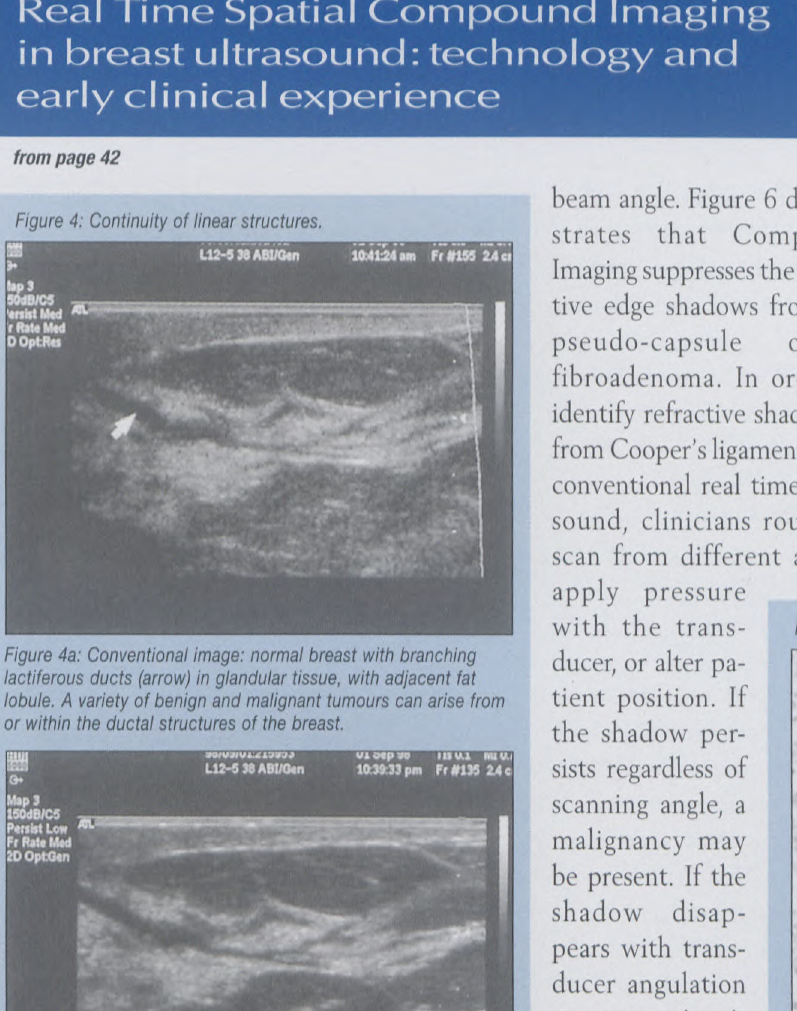
Figure 4b: Compound image: compounding improves delineation of ductal branches, which appear at numerous angular orientations. Improved continuity of linear striations within the surrounding fat lobule is also noted.